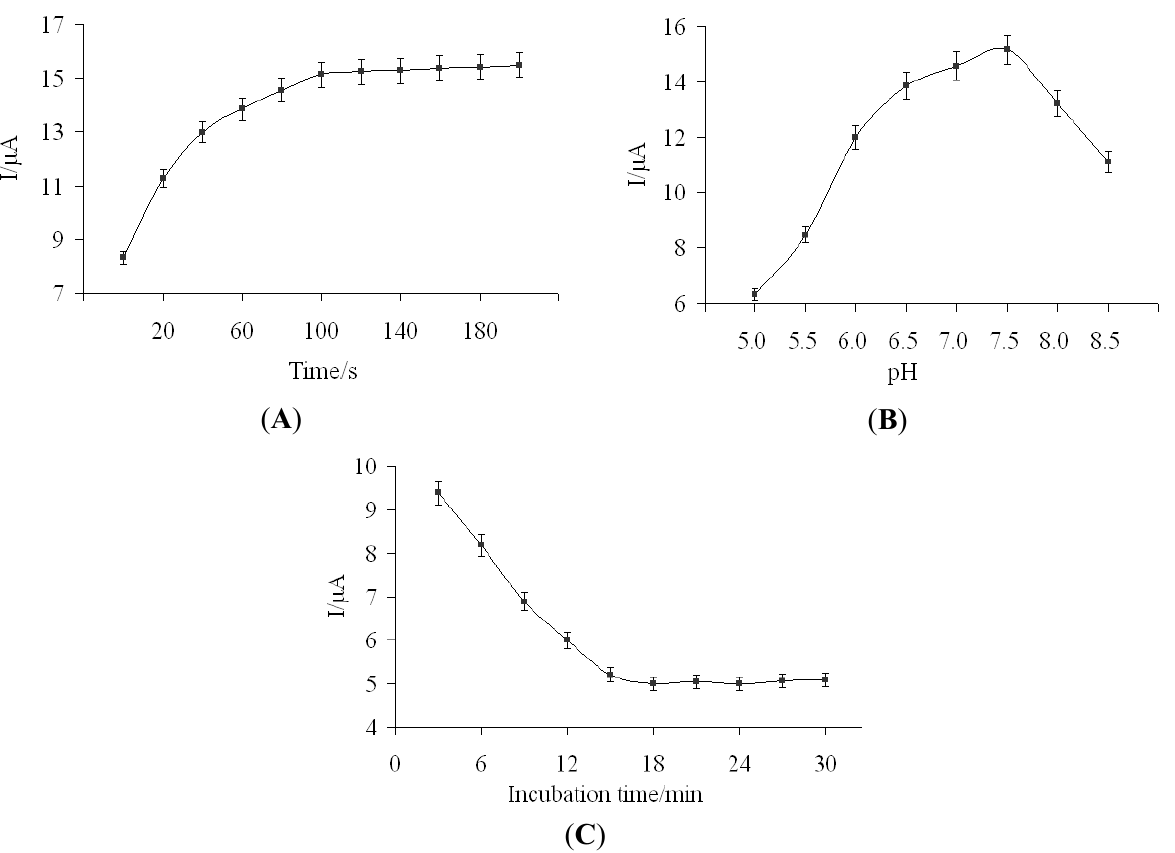
Figure 4. Effect of the electrodeposition time of DpAu ( A ), the pH of 5 mM [Fe(CN) ( B ) and the incubation time ( C ) on the immunosensor